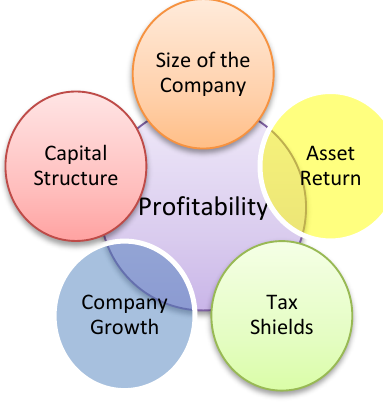
Figure 1: Conceptual model of the research